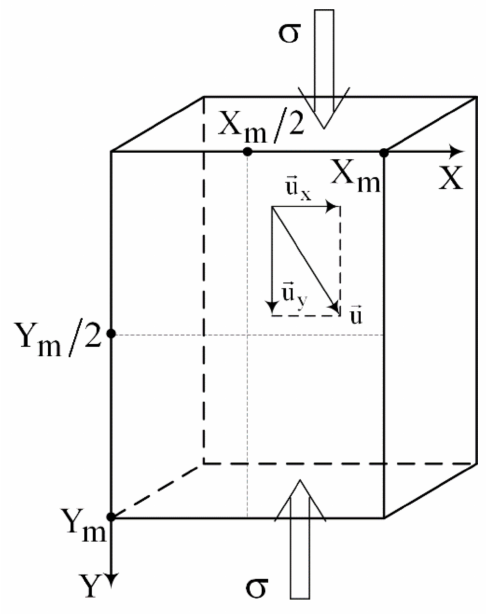
Figure 2. Compression loading diagram and coordinate